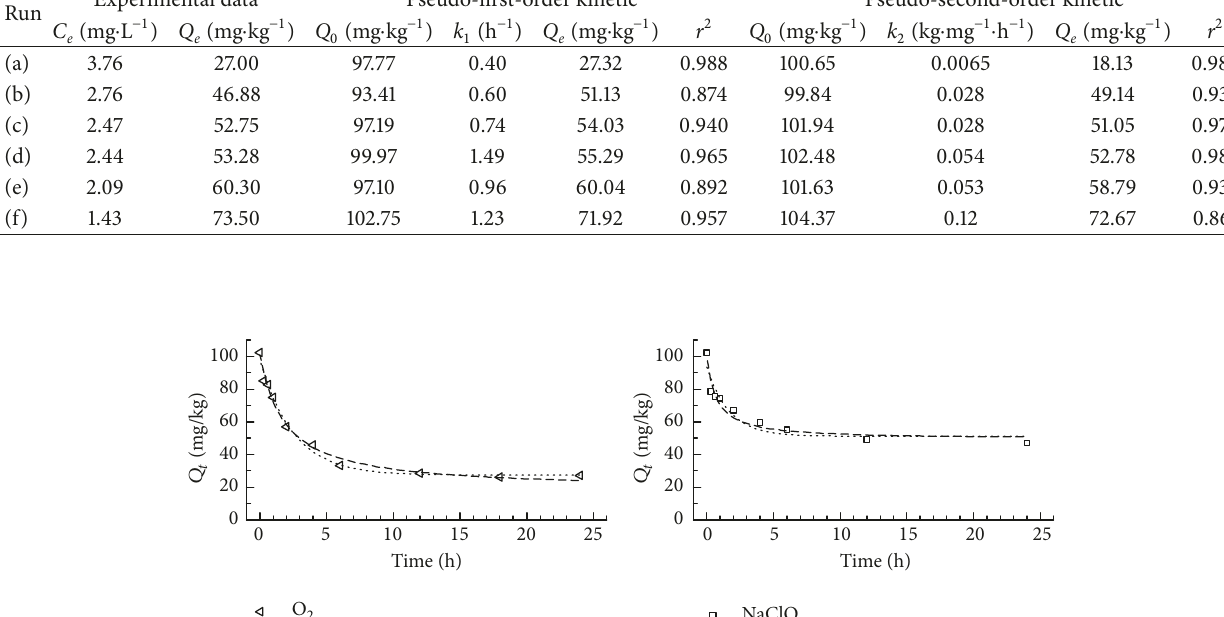
Table 2: Kinetic parameters for the leaching of uranium from the lignite. Experimental data Run